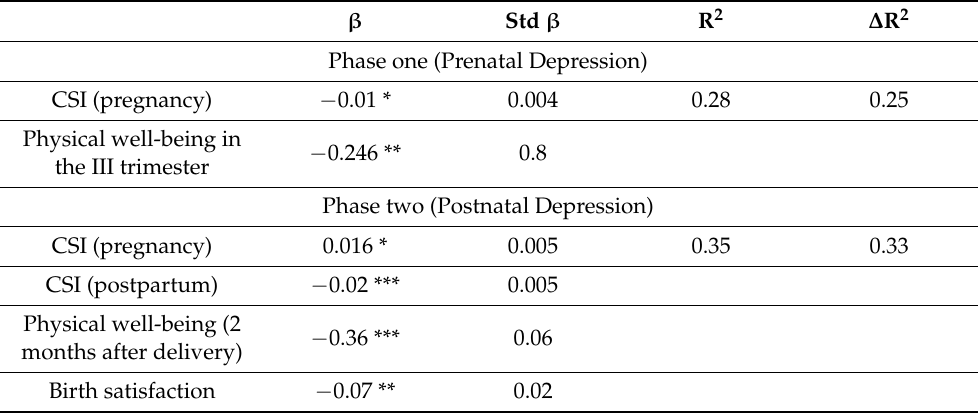
Table 3. Linear regression results examining associations with prenatal depression at phase one and postnatal depression at phase two of the longitudinal